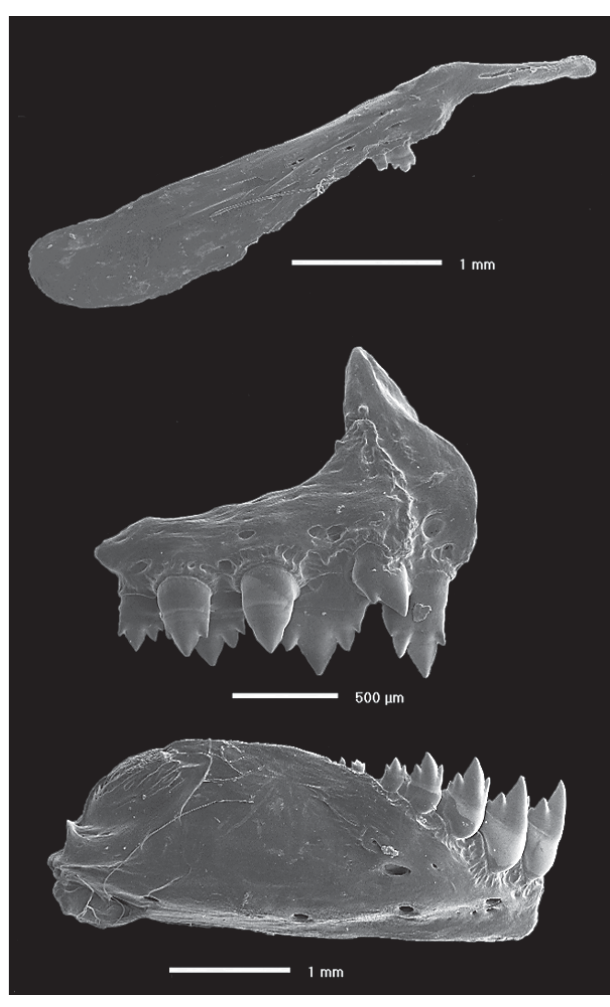
Fig. 2. Hyphessobrycon hamatus , MCP 33930, paratype, 38.3 mm SL. SEM photograph of right side maxillary (top), premax- illary (middle), and dentary (bottom) teeth.